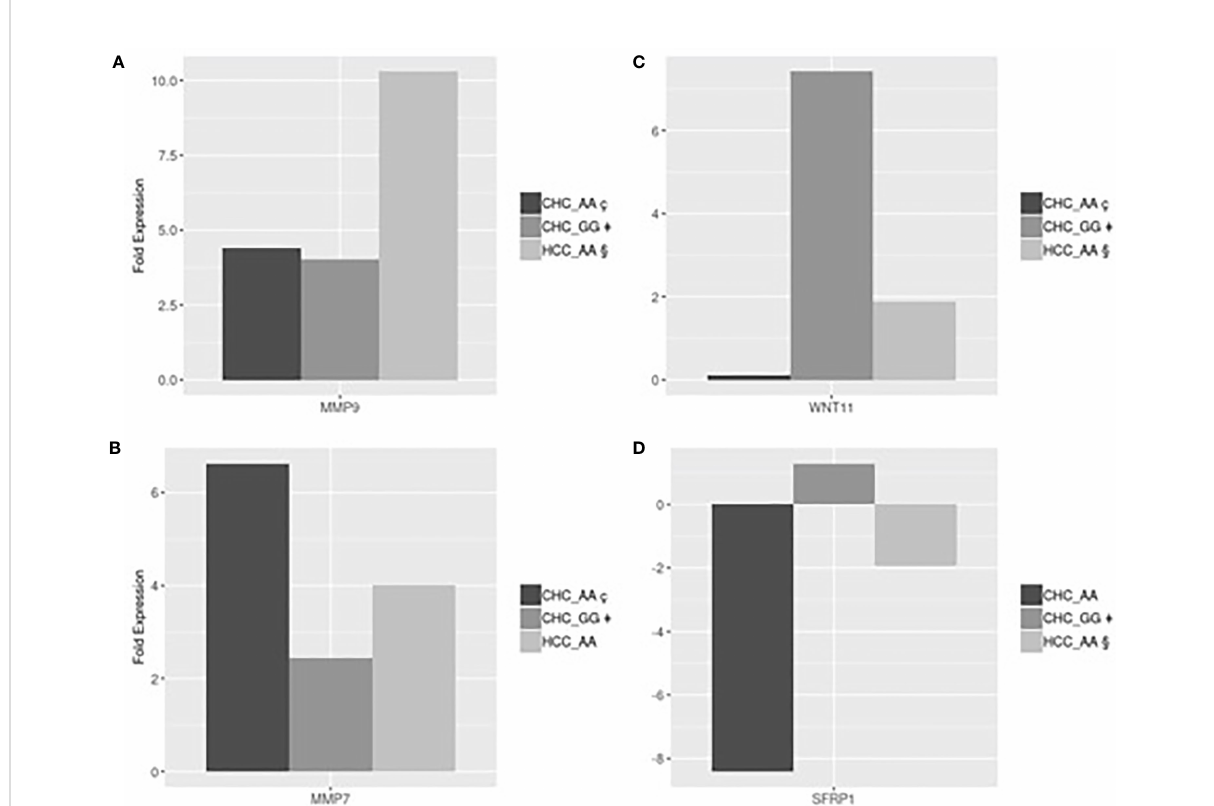
FIGURE 2 (A) HCC-AA vs CHC-AA and CHC-GG: statistically signi fi cant mean fold changes for MMP9 gene. PMMP9_§c ̧ =0.045, PMMP9_§ ‡ =0.04; (B) CHC-AA vs CHC-GG: statistically signi fi cant mean fold changes for MMP7 gene. PMMP7_ c ̧ ‡ =0.01; (C) CHC-GG vs HCC-AA and vs CHC-AA: statistically signi fi cant mean fold changes for WNT11 gene. PWNT11_§ ‡ =0.04; PWNT11_c ̧ ‡ =0.03; (D) HCC-AA vs CHC-GG: statistically signi fi cant mean fold changes for SFRPI gene. PSFRPI § ‡